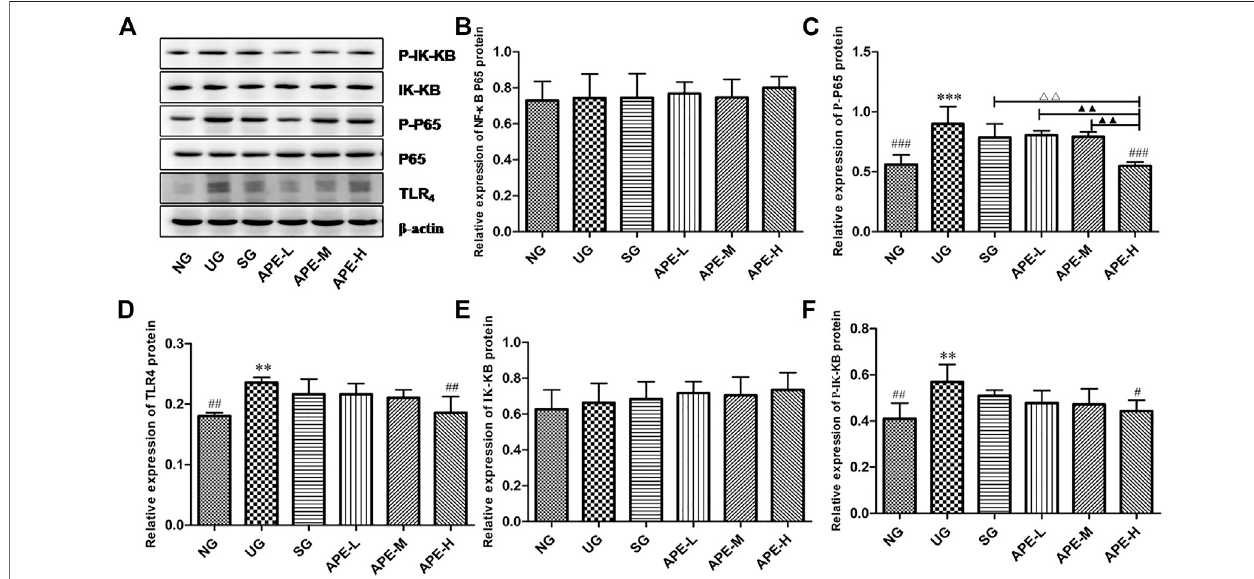
FIGURE 8 | Effects of APE on the levels of relative protein of TLR 4 dependent NF- κ B signaling pathway in the ulcerative colitis mice. (A) Western blot analysis demonstratedthe effects ofAPEon thelevels ofkeyprotein moleculesinvolvedintheTLR 4 /NF- κ Bsignalingpathway. (B) Relative expression levels ofNF- κ B. (C) p-NF- κ B. (D) TLR β . (F) p-IK-K β . * p < 0.05, ** p < 0.01, *** p < 0.001 vs. NG. # p < 0.05, # # p < 0.01 vs. UG. △ p < 0.05, △△ p < 0.01 vs. SG. ▲ p < 0.05, ▲▲ p < 0.01 vs. 4 . (E) IK-K APE-H.NF- κ B, nuclear factor-kappa B; TLR 4 ,toll-like receptor 4; p-NF- κ B, phosphorylation of NF- κ B p65; IK-K β , inhibitor kappa B-Kinase β ; p-IK-K β , phosphorylation of p-IK-K β ; NG, normal group; UG, ulcerative colitis model group. SG,sulfasalazine control group. APE-H,high-dose APE group; APE-M, middle-dose APE group; APE-L, low-dose APE